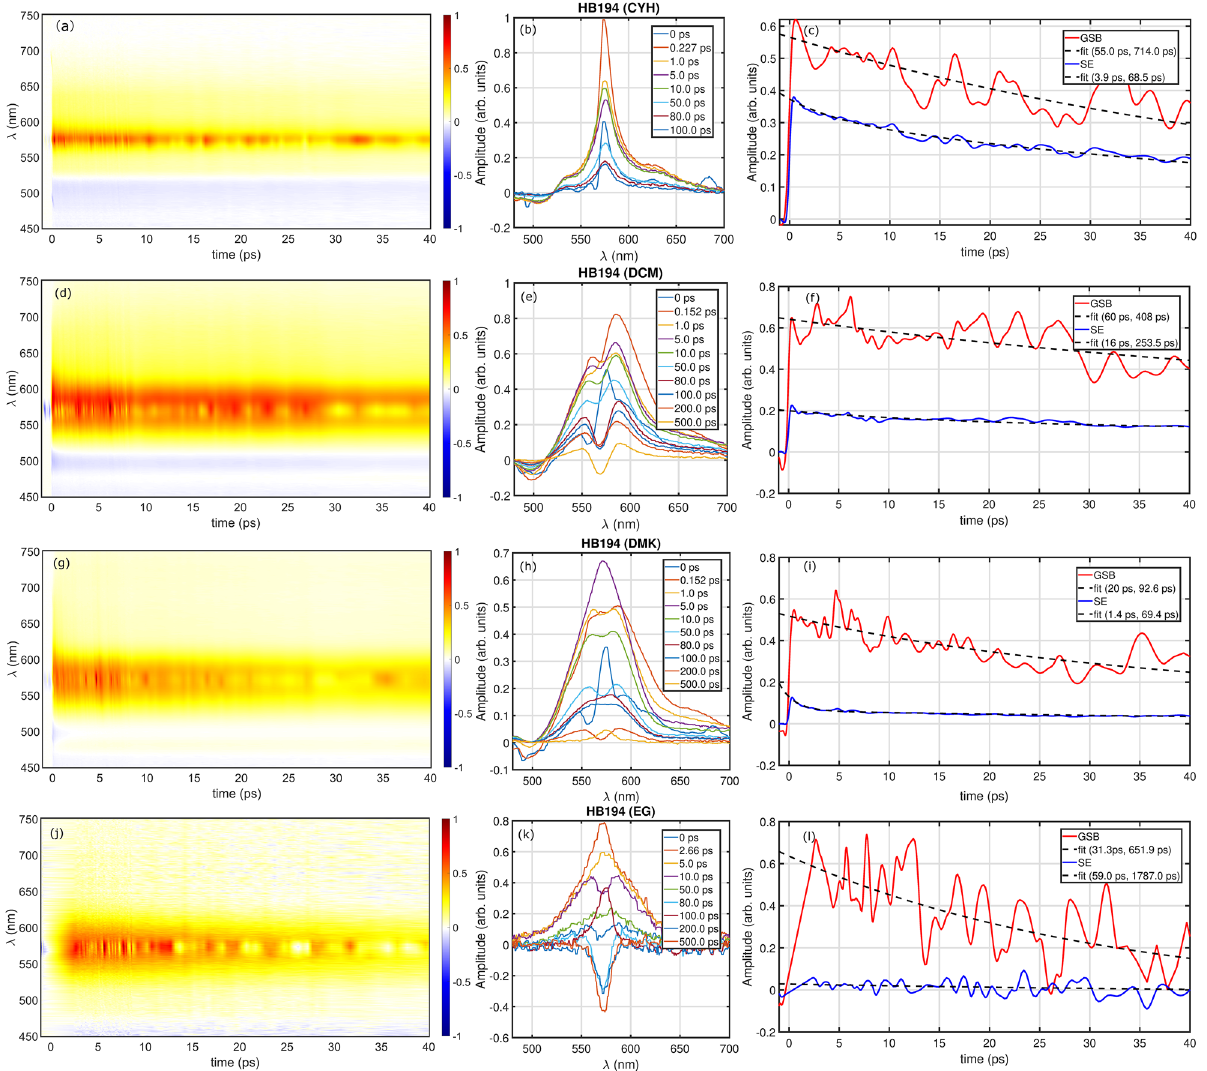
Figure 2. Experimental transient absorption (TA) measurements. The TA spectra of HB194 solutions in CYH ( a ), DCM ( d ), DMK ( g ) and EG ( j ) with wavelength of pump excitation at 570 nm. The transient spectra shown here are plotted as differential transmission of probe in the range of 450–750 nm. The spectral profiles at selected waiting times are plotted as solid lines in ( b ), ( e ), ( h ) and ( k ). The kinetic traces of ground state bleach (GSB) and stimulated emission (SE) are shown here as red and blue solid lines in ( c ), ( f ), ( i ) and ( l ), respectively. The instrument response function of the TA instrument was ∼ 120